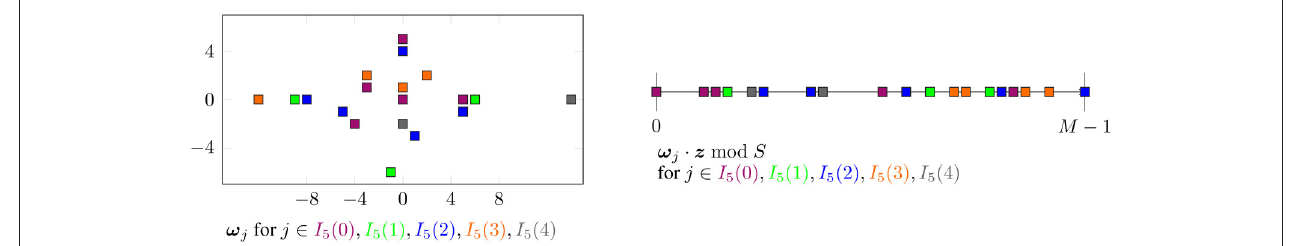
FIGURE 2 | Illustration of an example frequency index set { ω j } 19 j = 1 and corresponding one-dimensional frequencies ω j · z mod S partitioned by I P ( ℓ ) with parameters P : = 5 , z : = (1 , 33) T , S : = 37